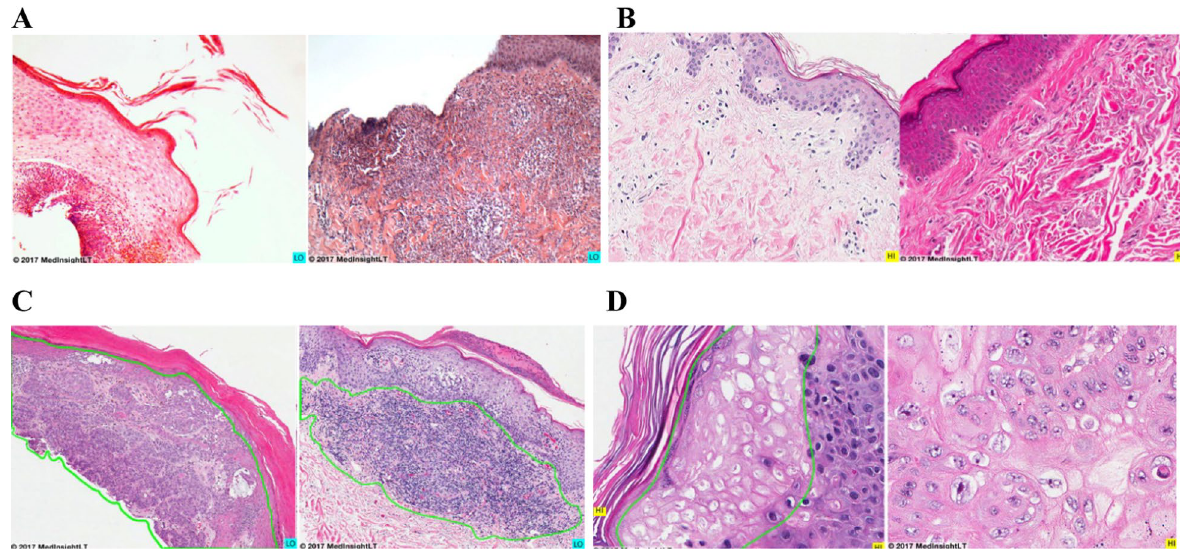
Fig. 1 A Two examples of acute inflammation having very different global and local perceptual features. B Two examples of normal histology having very different global and local perceptual features. C The histopathology of an example of Neoplasia (left) and of chronic inflammation (right) having very similar local features (here highlighted by green borders which are only presented here for the reader and were not presented to participants) which are needed to identify the category. D The histopathology of an example of cell and tissue injury/repair (left) and of neoplasia (right) having very similar local regions (again highlighted by green borders which are only presented here for the reader and were not presented to participants) which are needed to identify the